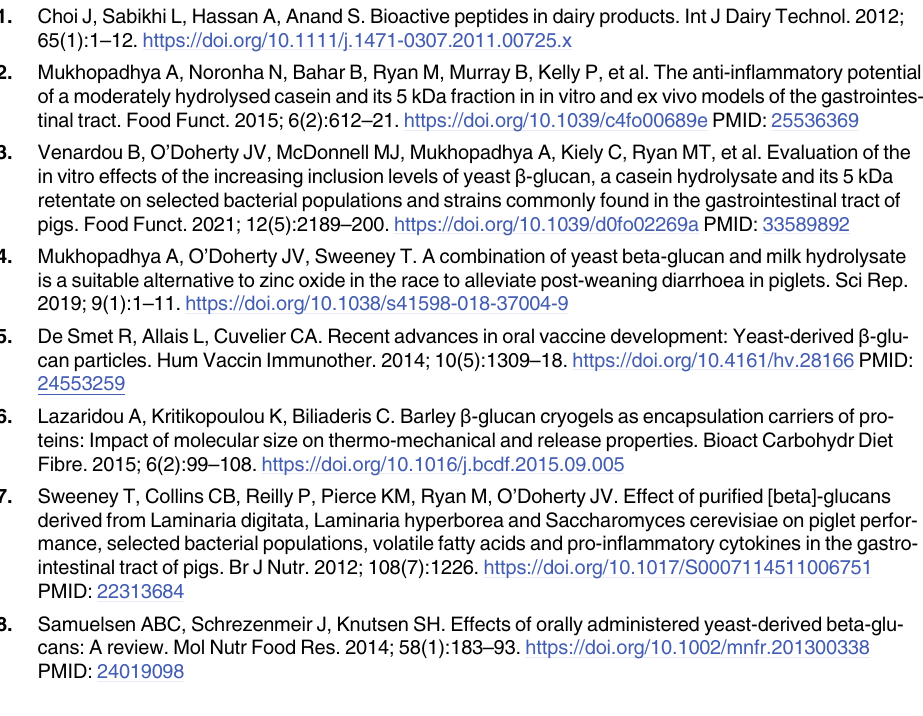
S2 File. Effect of supplementation of CH-YBG during gestation/lactation and/or post- weaning on differential relative abundance of bacterial taxa at the phylum, family and genus levels in pig colonic digesta on day 10 post-weaning. BB basal sow, basal pig; BS